Question: Looking at the figure, what chart type is it?
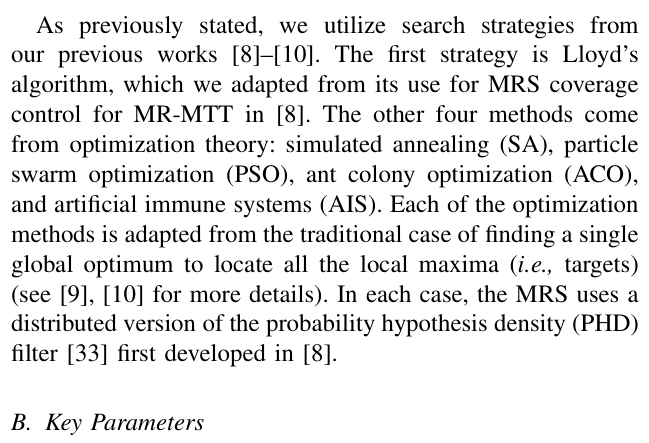
Answer: line